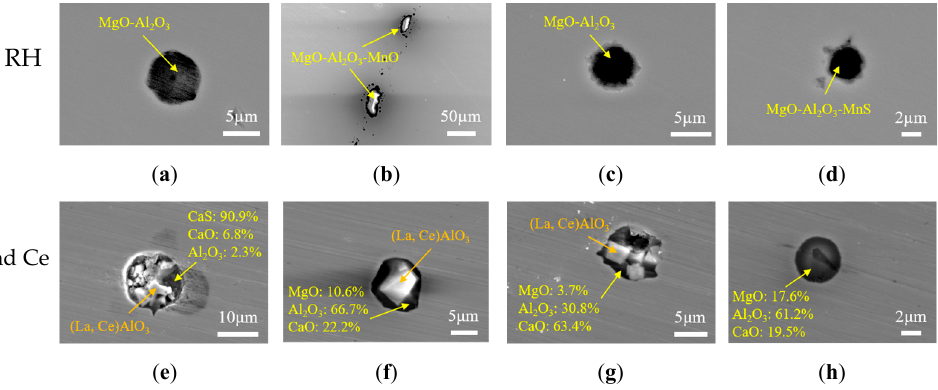
Figure 10. Morphologies and compositions of inclusions, before and after rare earth treatment, after RH alloying . ( a ) Al 2 O 3 -MgO; ( b )MgO-Al 2 O 3 -MnO; ( c ) Al 2 O 3 -MgO; ( d ) Al 2 O 3 -MgO-MnS; ( e ) (La,Ce)AlO 3+ Al 2 O 3 -CaO-CaS; ( f ) (La,Ce)AlO 3+ Al 2 O 3 - MgO-CaO; ( g ) (La,Ce)AlO 3+ Al 2 O 3 - MgO-CaO; ( h ) Al 2 O 3 - MgO-CaO